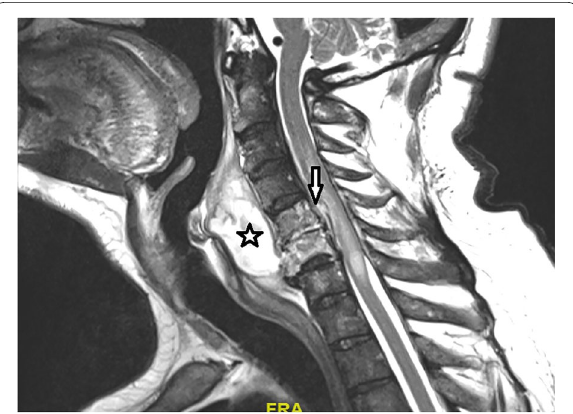
Fig. 2 T2-weighted, sagittal section of vertebra MRI: the star shows the retropharyngeal abscess, and the arrow show the spinal epidural abscess. Myelopathic signal changes of the spinal cord are clearly